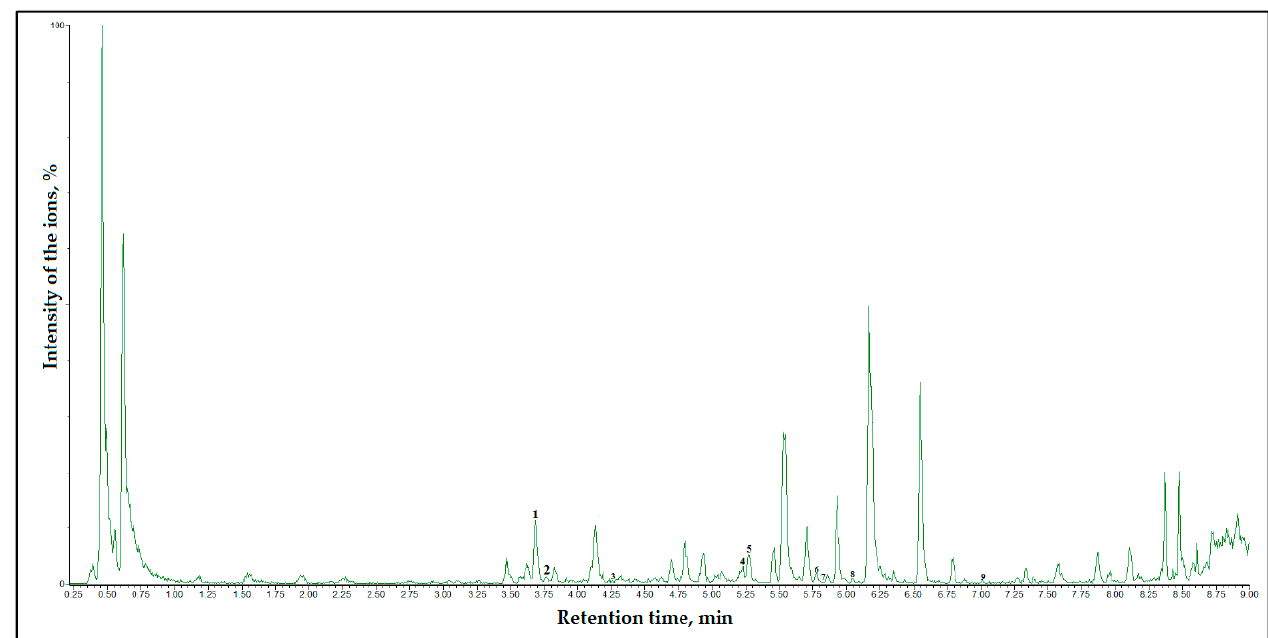
Figure 4. UHPLC chromatogram of fruit extract of R. multiflora (cultivar “Nana”). The numbers indicate the compounds identified: 1—(+)-catechin, 2—chlorogenic acid, 3—( − )-epicatechin, 4—rutin, 5—( − )-epicatechin gallate, 6—kaempferol-3-O-glucoside, 7—quercitrin, 8—phloridzin, and 9—quercetin.